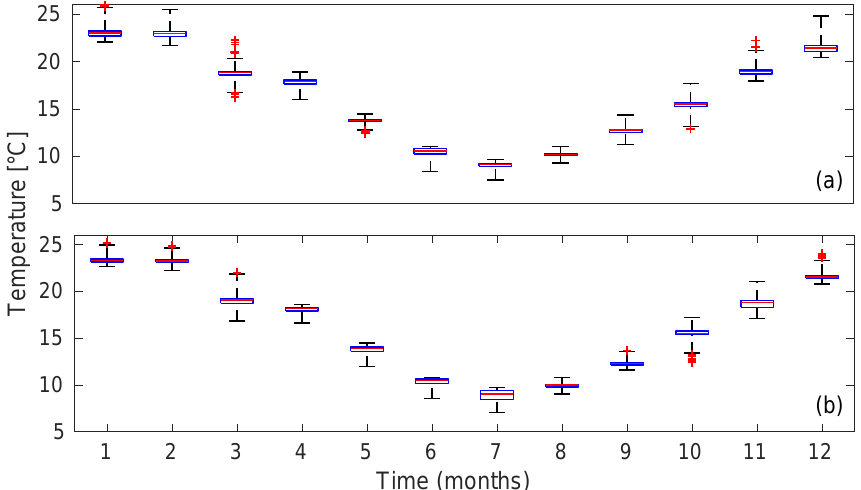
Figure 6. Boxplot of the monthly climatology of the LSWT of San Pedro lagoons. ( a ) Laguna Grande and ( b ) Laguna Chica. Outliers in